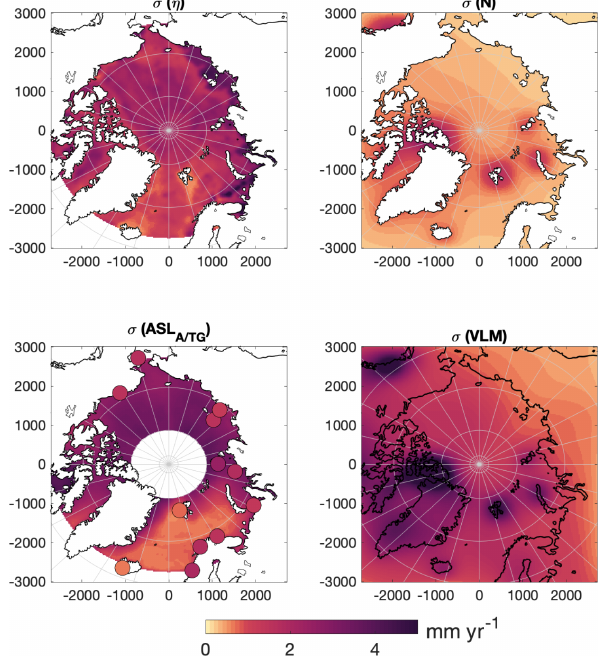
Figure 11. Standard error (68% confidence interval) of the 1995– 2015 trend [mmyr − 1 ] for combined steric, combined ˙ N , ˙ ASL A / TG and combined VLM